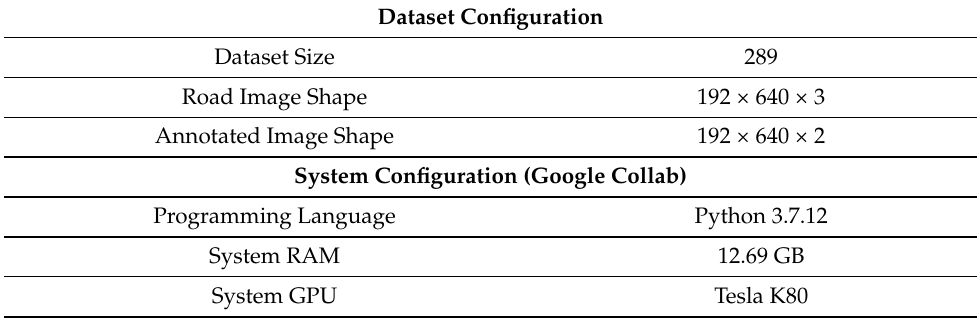
Table 6. Dataset and system